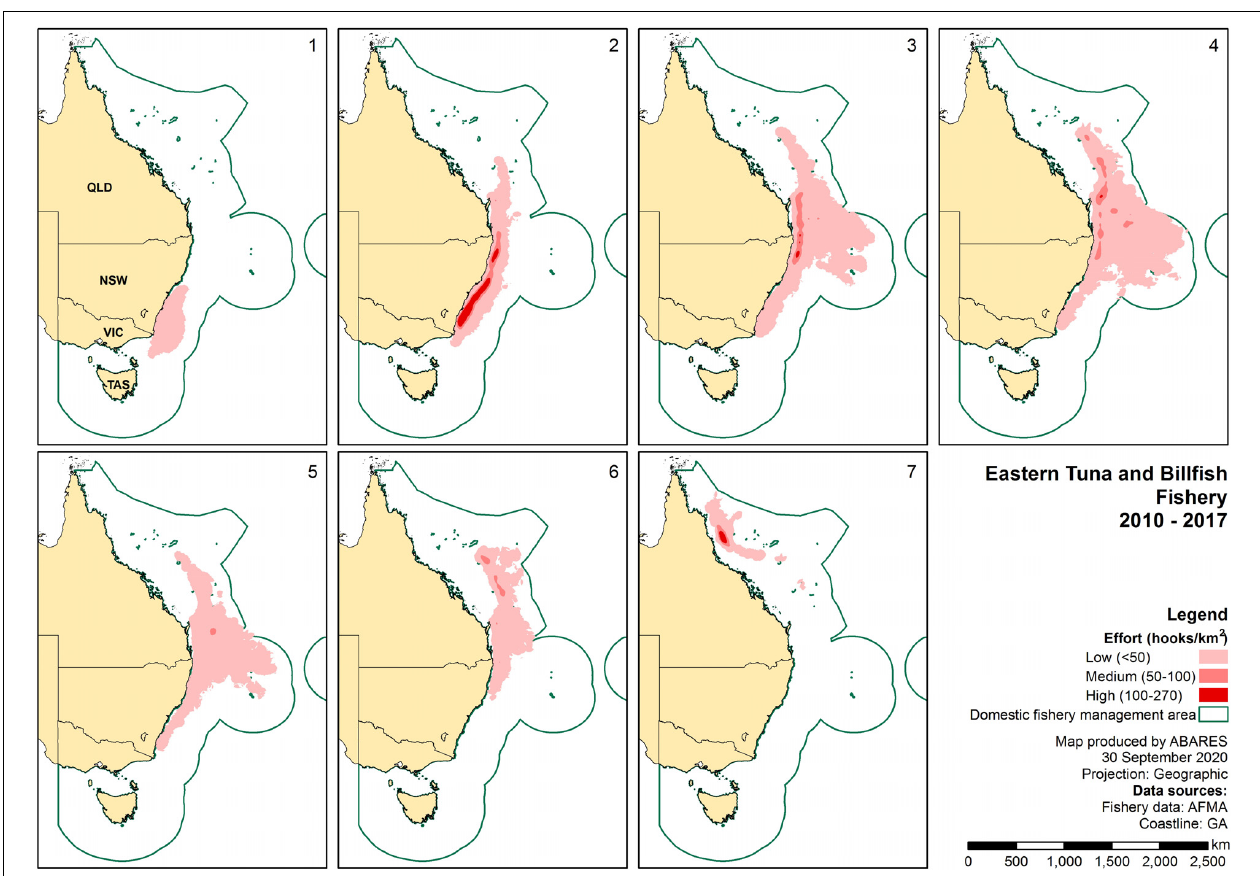
FIGURE 6 | Area and relative fishing intensity of the seven métiers identified in the Eastern Tuna and Billfish Fishery (ETBF) between 2010 and 2017 calendar years.